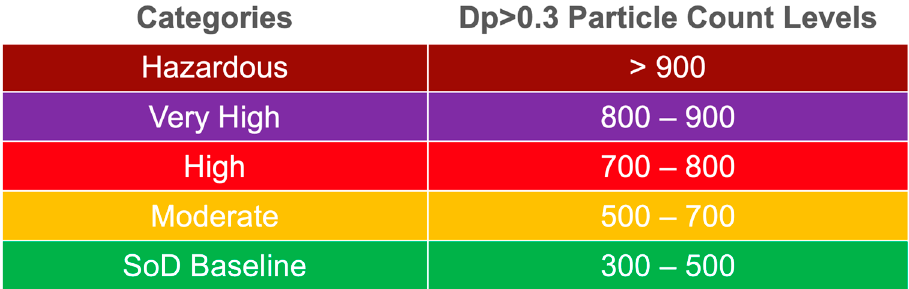
Figure 9. Five categories were chosen to represent different levels of exposure rates. The SoD baseline was calculated separately during active hours. The categories were defined using the same structure as PM 2.5 published by EPA [37].